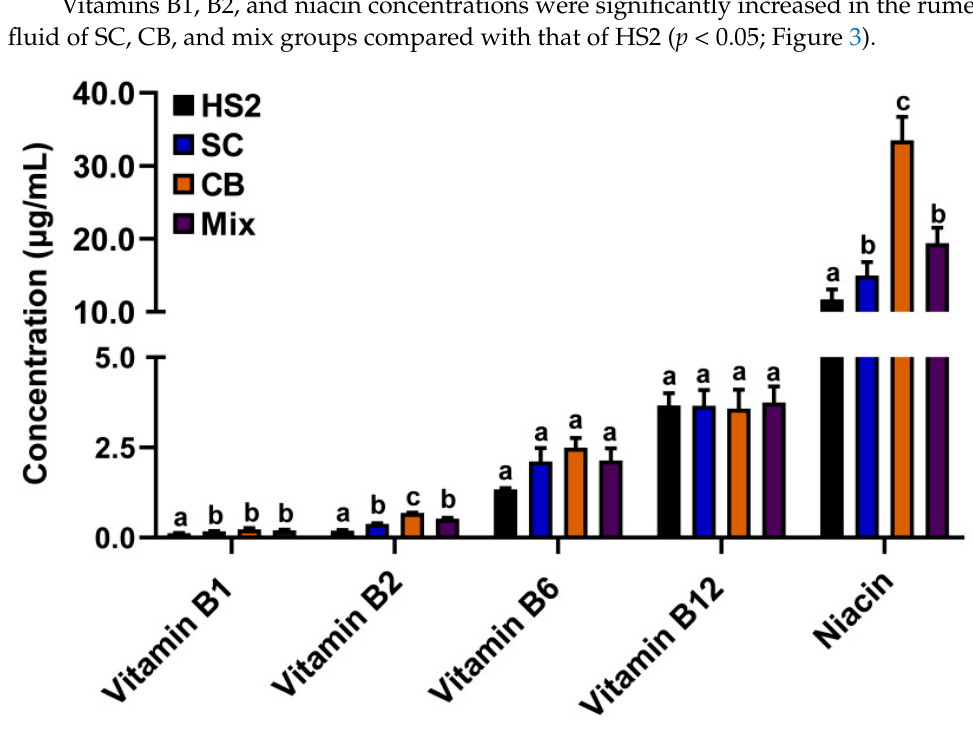
Table 5. The growth performance parameters of the heat-stressed goats supplemented with Clos- tridium butyricum and Saccharomyces cerevisiae .